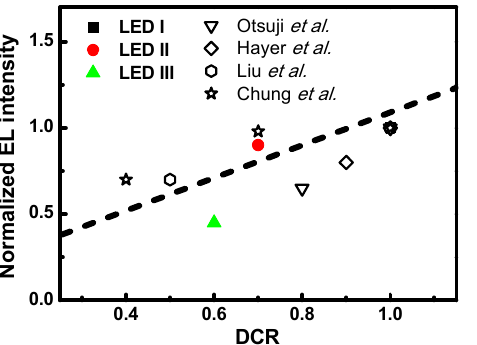
Figure 8. Normalized EL intensity as a function of DCR for devices LED I, LED II, and LED III. Table 1. Experimental data published in previous reports of thermally introduced resistance from current-voltage measurements with different kind of heterostructure configuration for estimation of the Debye temperature and electron–phonon coupling.